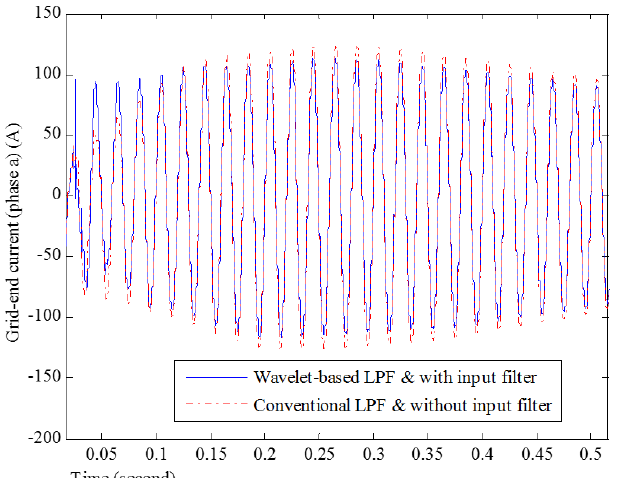
Figure 13. Comparison of transient response time of compensated grid-end current (Phase A) by the conventional low-pass filter and by the proposed wavelet-based low-pass filter, together with the suggested input filter under sun irradiation variation from 1000 W/m 2 to 750 W/m 2 at 0.025 s.